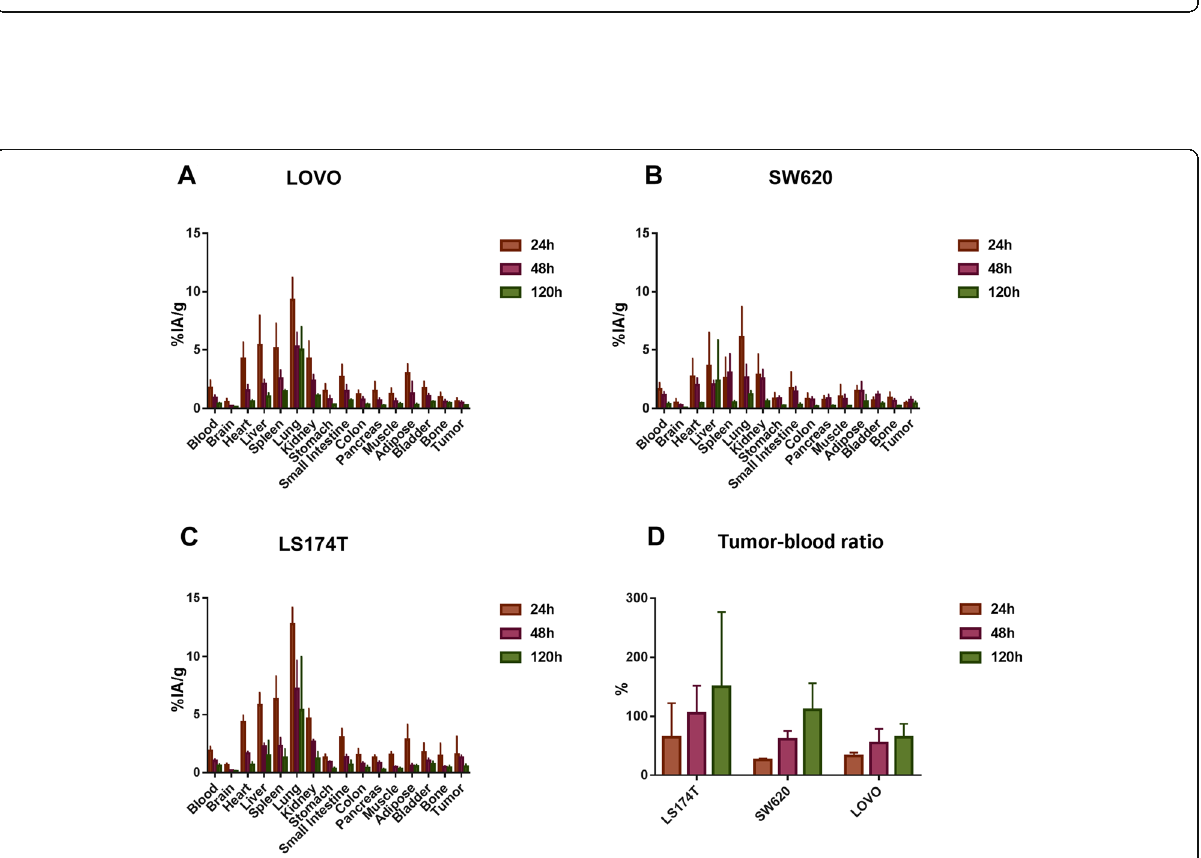
Fig. 5 Ex vivo biodistribution of 131 I-PD-L1-Mab in SW620 ( a ), LoVo ( b ), and LS174T ( c ) tumor-bearing nude mice at 24 h, 48 h, and 120 h after injection. The mean (%IA/g) ± SD at each time point after injection ( n = 4 mice at each time point). d Corresponding quantitative data of the tumor (%IA/g)-to-blood (%IA/g) ratio of SW620, LoVo, and LS174T tumor-bearing nude